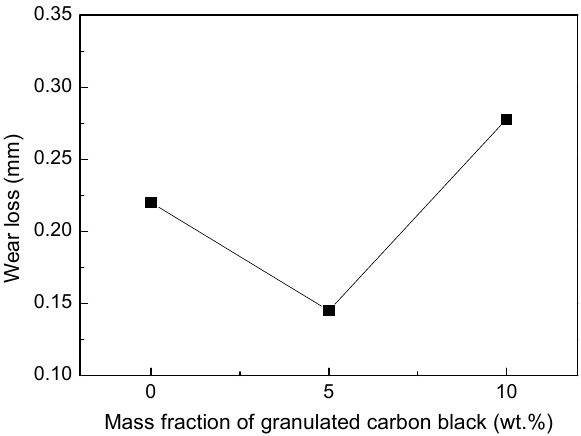
Figure 10. Effect of mass fraction of granulated carbon black on wear loss of materials.